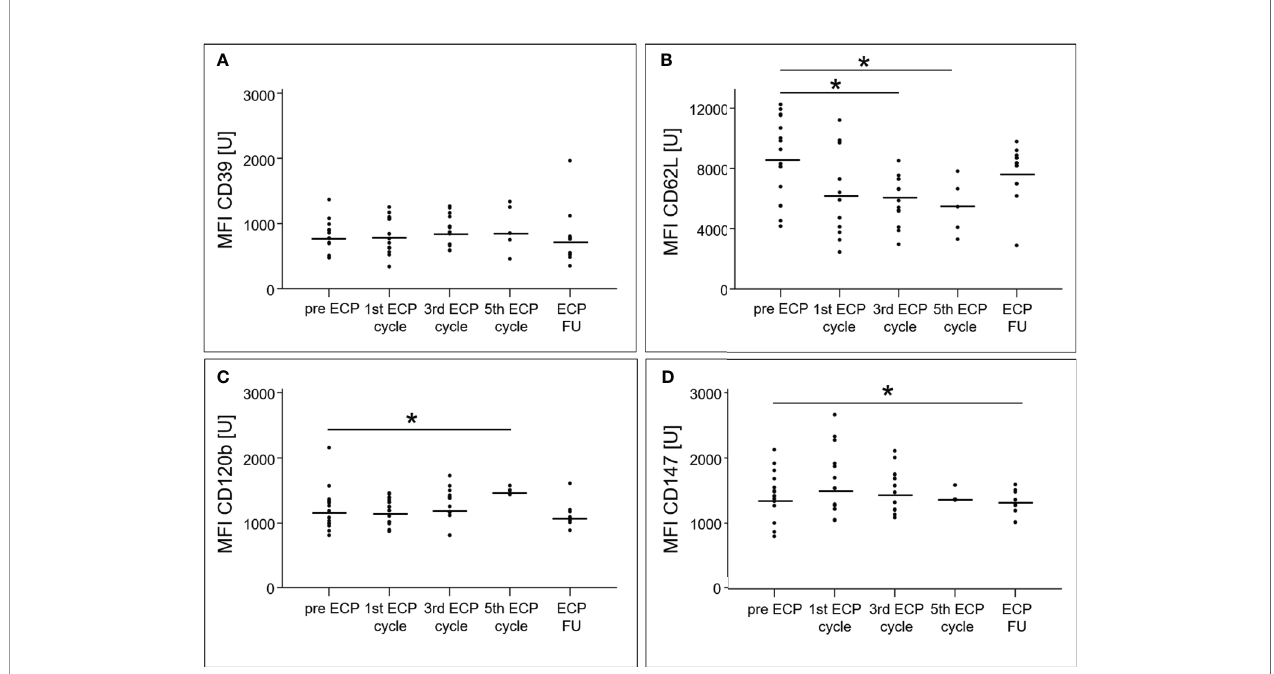
FIGURE 5 | Mean fl uorescence intensities of the surface molecules CD39 (A) , CD62L (B) , CD120b (C) and CD147 (D) of regulatory T cell subsets in heart- transplanted patients receiving extracorporeal photopheresis. * marks signi fi cant differences (p ≤ 0.05); CD, cluster of differentiation; ECP, extracorporeal photopheresis; FU, follow-up; MFI, mean fl uorescence intensity; U,